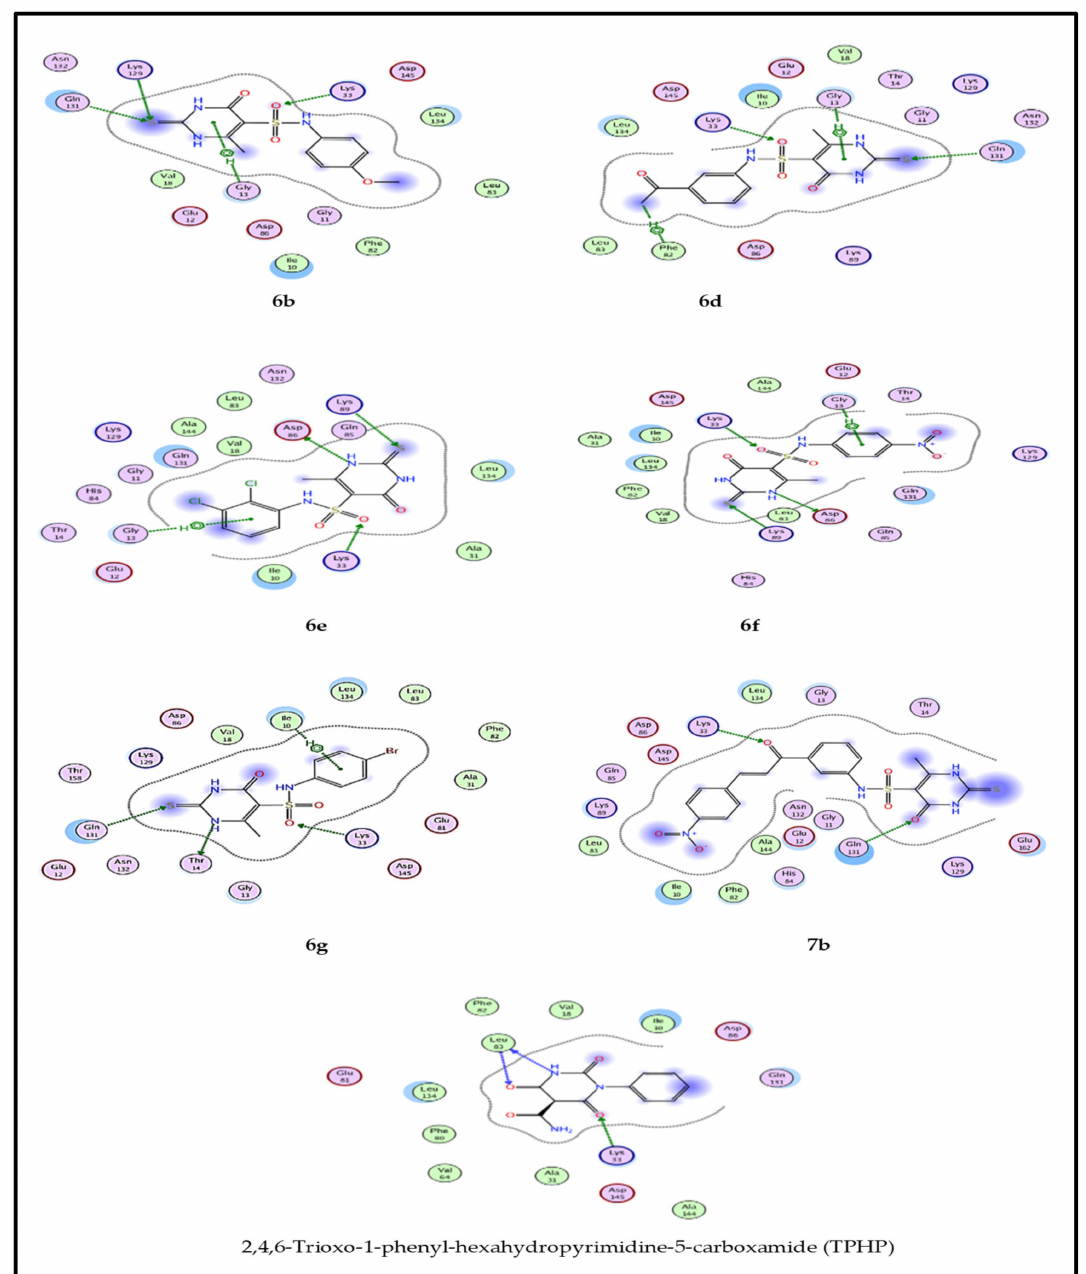
Figure 7. 2D binding mode of compounds 6b, 6d–g, 7b and TPHP with CDK2 ATP binding